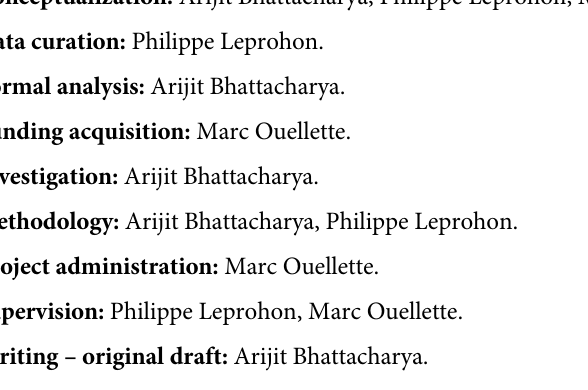
S1 Table. List of PCR primers used in this study. S2 Table. Genes located on enriched cosmids. This table provides the list of genes located on cosmids enriched by MTX, 5-FU or PMX shown in Fig